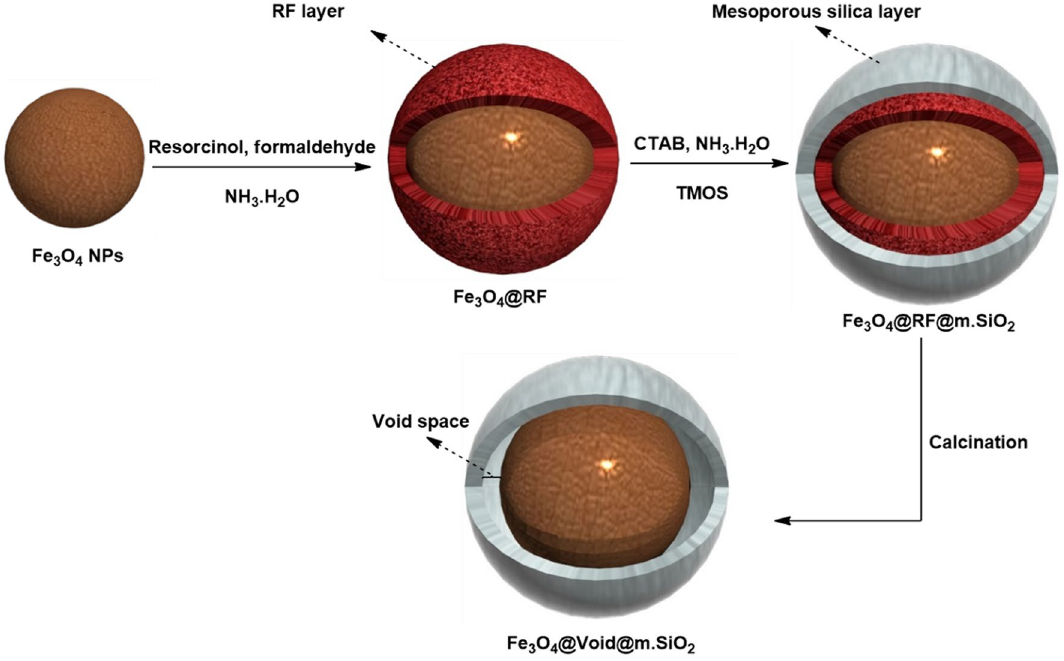
Figure 1. Preparation of Fe 3 O 4 @Void@m.SiO 2